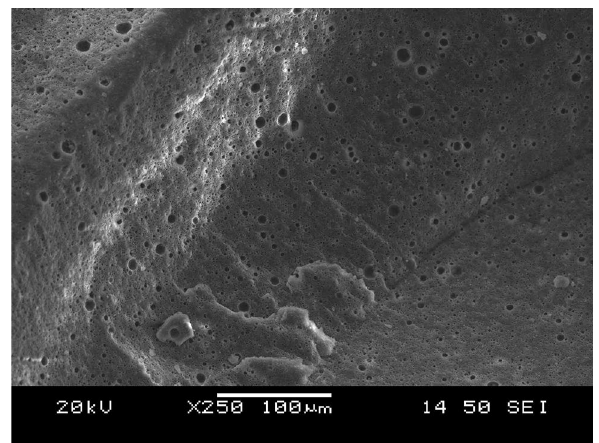
selenite adsorption. c Langmuir isotherm for selenate adsorption. d Freundlich isotherm for selenate